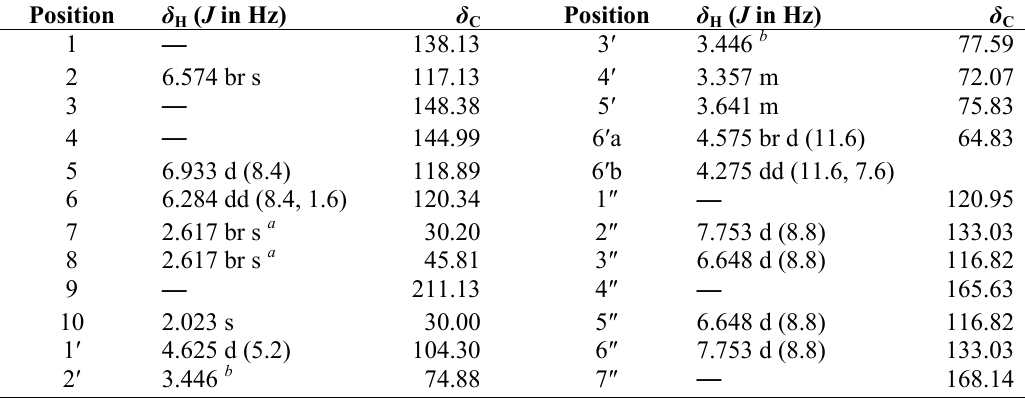
Table 1. 1 H- and 13 C-NMR data of 1 (in methanol- d